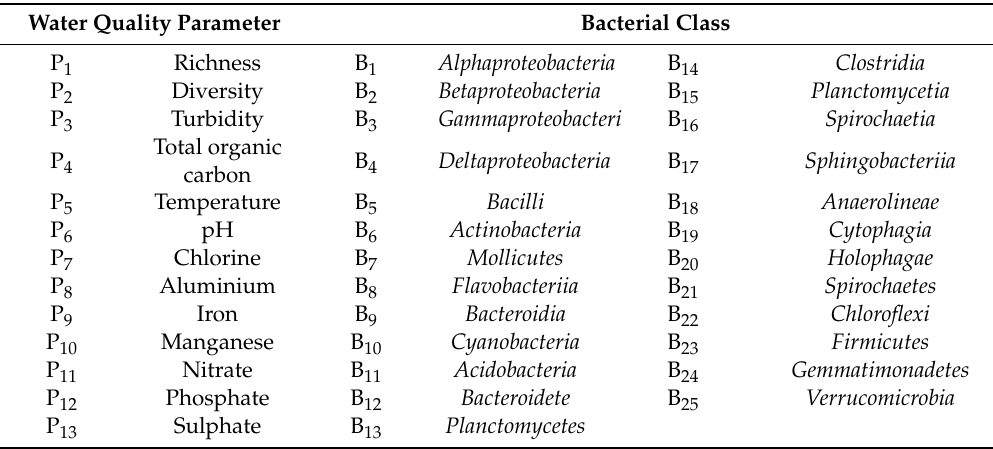
Table 1. Factors taken into account for the multi-criteria decision-making (MCDM) analysis. Water Quality